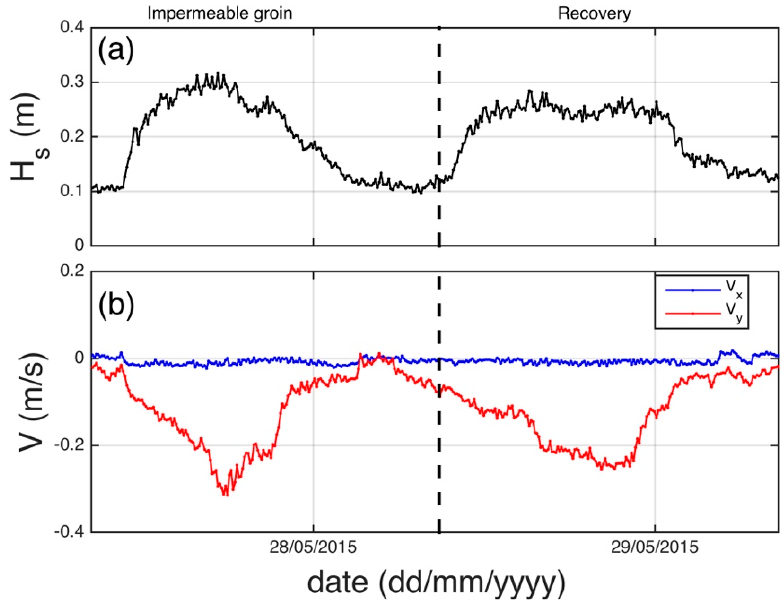
Figure 8. Surf zone conditions during and 24 h after the structure disturbance. ( a ) Significant wave height inside the surf zone and ( b ) cross- (blue line) and along- (red line) shore currents. Negative values in panel ( b ) indicate offshore/west-ward currents, while positive values indicate onshore/east-ward currents.